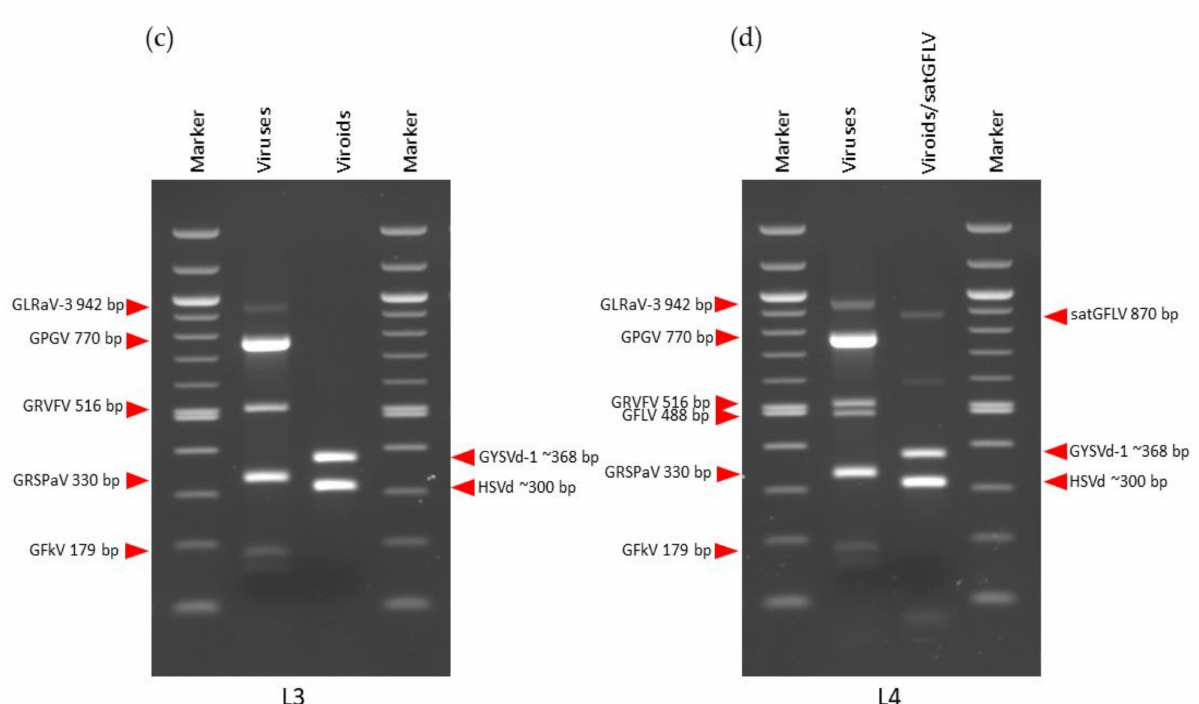
Figure 3. Validation of sRNA-seq-predicted viruses and virus-like organisms with mRT-PCR: ( a ) L1; ( b ) L2; ( c ) L3; ( d )